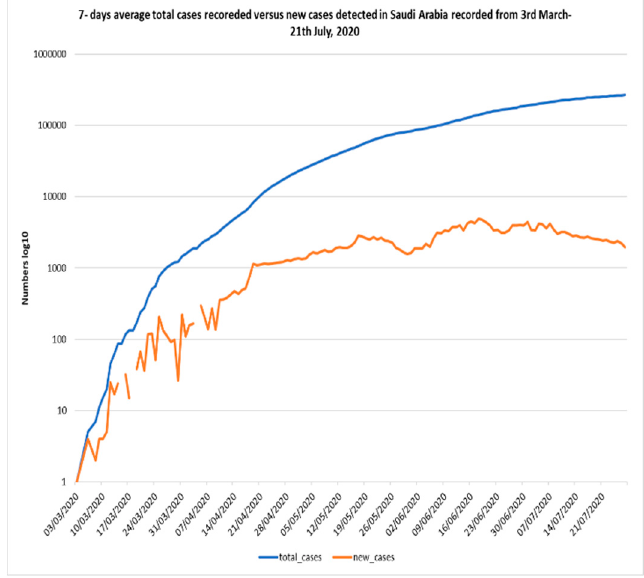
Figure 1. COVID-19 7-days average total cases versus new cases recorded in Saudi Arabia recorded from 3 March–21 July 2020 ( Using logarithmic scale based 10 ).